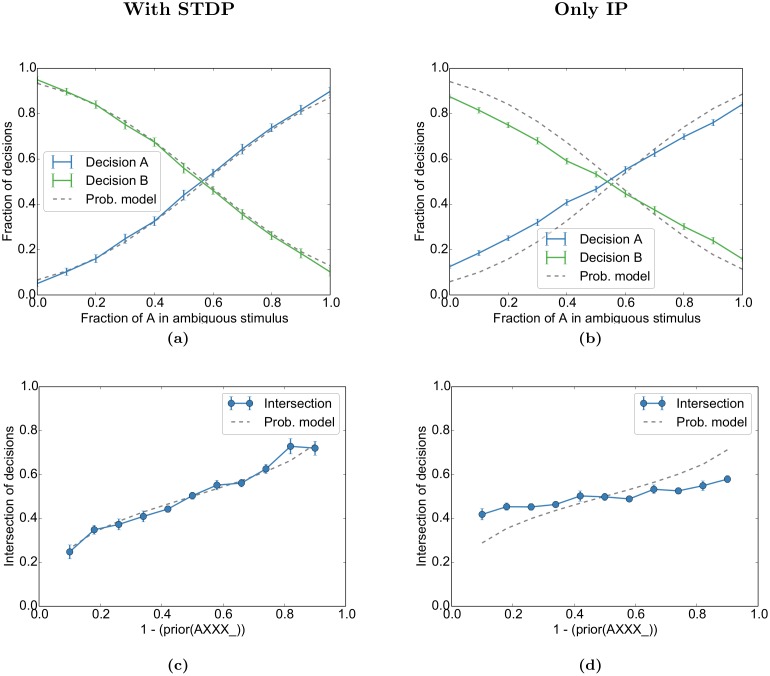
Prior and ambiguous information is combined in network decisions.(a) As in Fig 6, the network self-organizes during repeated presentations of the sequences “AXXX_ _ _ …” (33%) and “BXXX_ _ _ …” (67%) with blank intervals in between. In the test phase, an ambiguous mix of cue “A” and cue “B” is presented (“A/BXXX_ _ _ …”) and the network decides at the first “_” with a linear classifier if either A or B was the start of the sequence. The fraction of decisions for “A” or “B” at the first blank state “_” approximates the integration of cue likelihood and prior stimulus probability as expected from the probabilistic model (grey dashed line) for the given prior (p(A) = 0.33). The probabilistic model was fitted by grid search over its two parameters to the parameters that had the smallest accumulated error over all priors. (b) For the “Only IP” condition, STDP was deactivated during the self-organization phase and a new probabilistic model was fitted. (c, d) The intersections of the decisions for different priors for our simulations (blue line) and the probabilistic model (grey dashed). The performance was evaluated for the same simulation as Figs 5 and 6. Error bars represent SEM over 20 independent realizations.